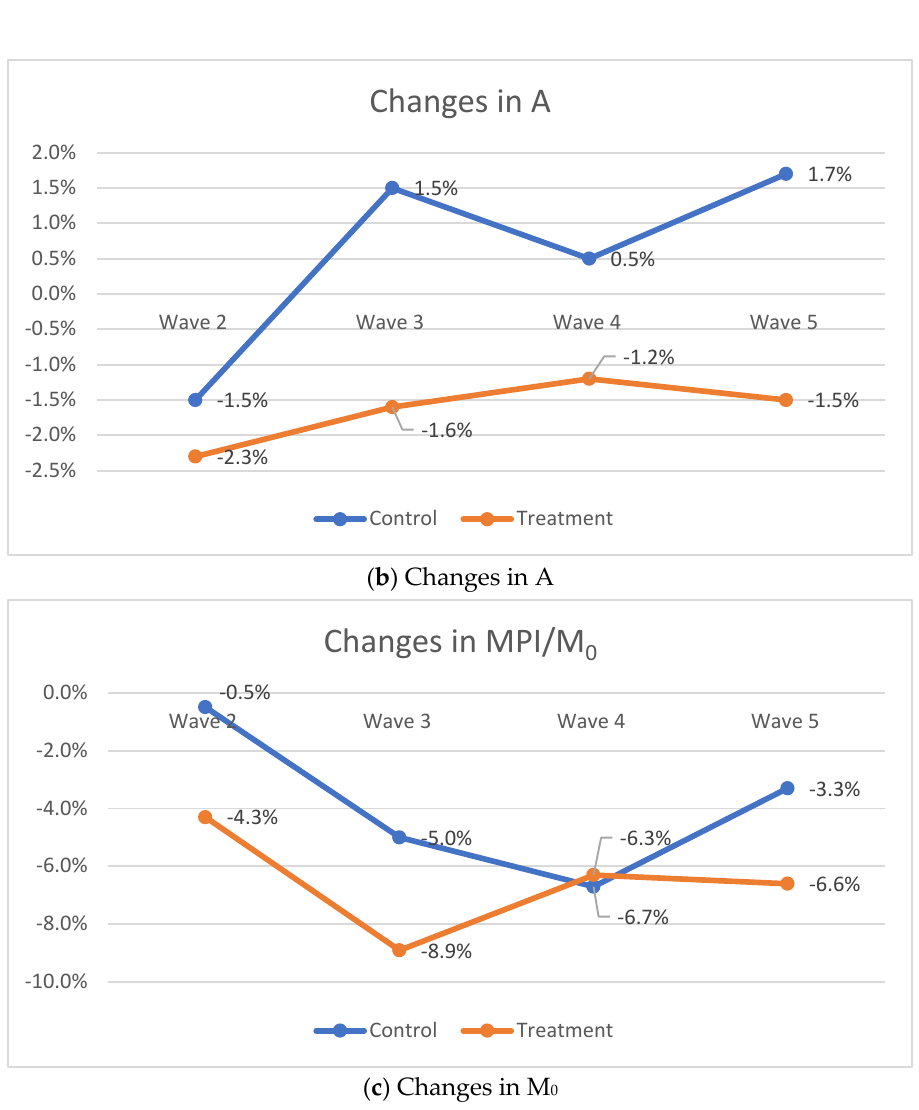
Figure 2. MPI Results: the changes between time points by study arms in percentage points.